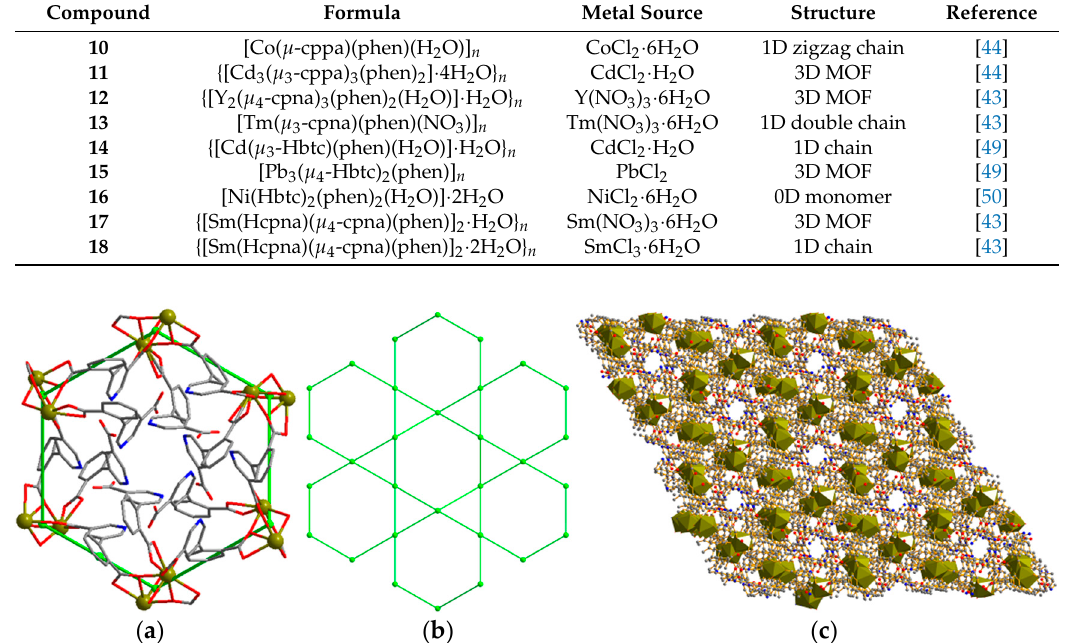
Figure 4. Structural fragments of MOF 17 . ( a ) Hexagonal Sm 12 macrocycle; green balls are Sm 2 units. ( b ) Interconnection of hexagonal macrocycles into a 2D layer motif; green balls are Sm 2 units. ( c ) 3D metal-organic framework. Adapted from [43].